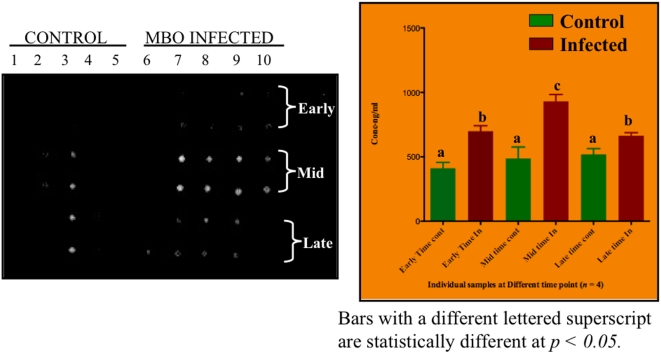
Validation of vitamin DBP in individual sera from M. bovis infected and control animals.Shown is a dot blot of levels of DBP in individual sera and the bar graph represents quantification of DBP in respective dots using densitometric analysis. Each spot contains 50-µg of total proteins from M. bovis infected and control sera. The first five lanes contain sera from control animals at first, third and fourth months. Lanes six to ten contains sera from M. bovis infection at 1, 3, and 4 months post infection. All sera were analyzed in duplicates.